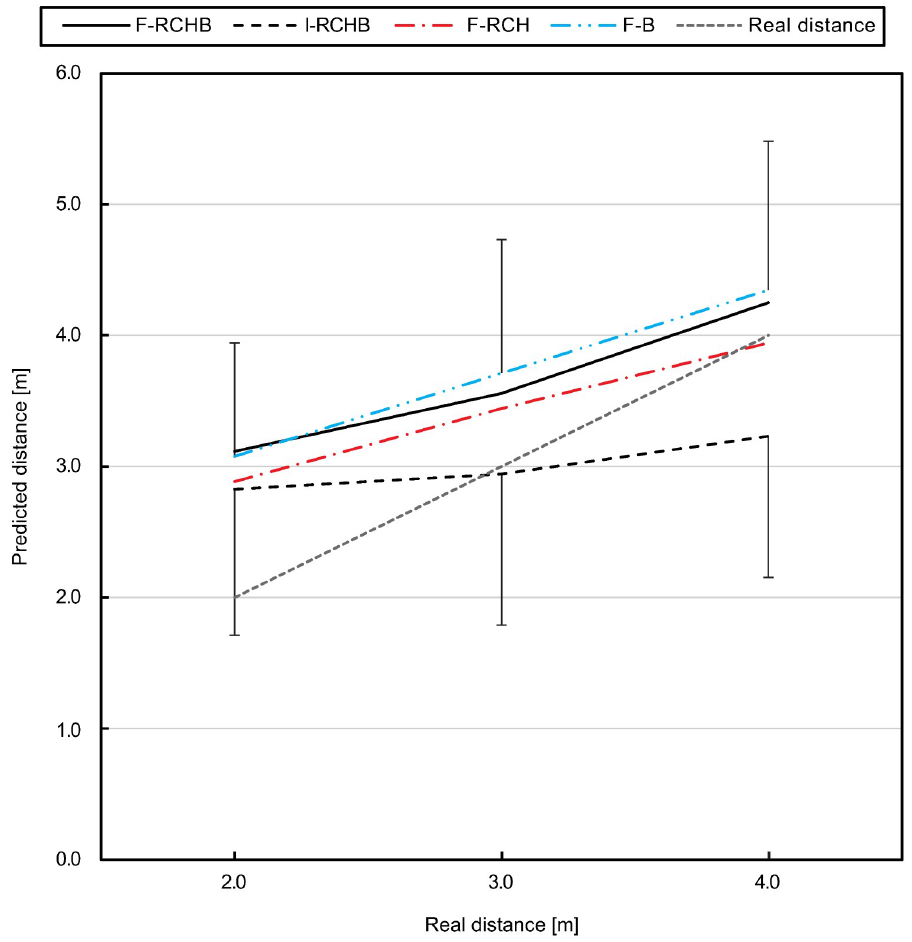
Fig 15. Predicted putting distance. Mean and standard deviation of the predicted putting distance under I-RCHB, F-RCHB, F-RCH, and F-B condition.